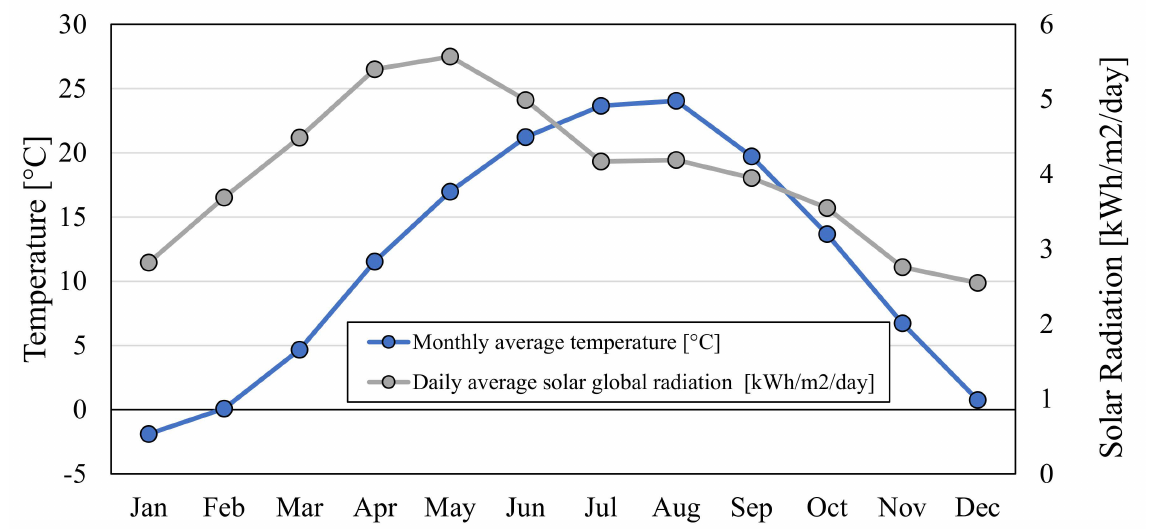
Figure 3. Monthly outdoor air temperature and solar